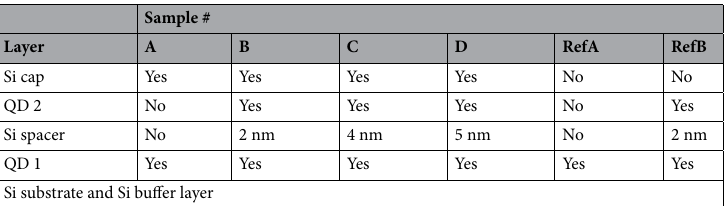
Table 1. Upright layer sequences of the samples used in this study. Samples A and RefA incorporate a single QD layer only, all other have vertically stacked QD pairs separated by the denoted Si spacer thicknesses. Samples RefA and RefB have no Si cap to allow for AFM imaging and nanotomography. All other samples are Si-capped for PL experiments and STEM imaging. The growth parameters for the individual layers are given in the “Methods” part of the text.